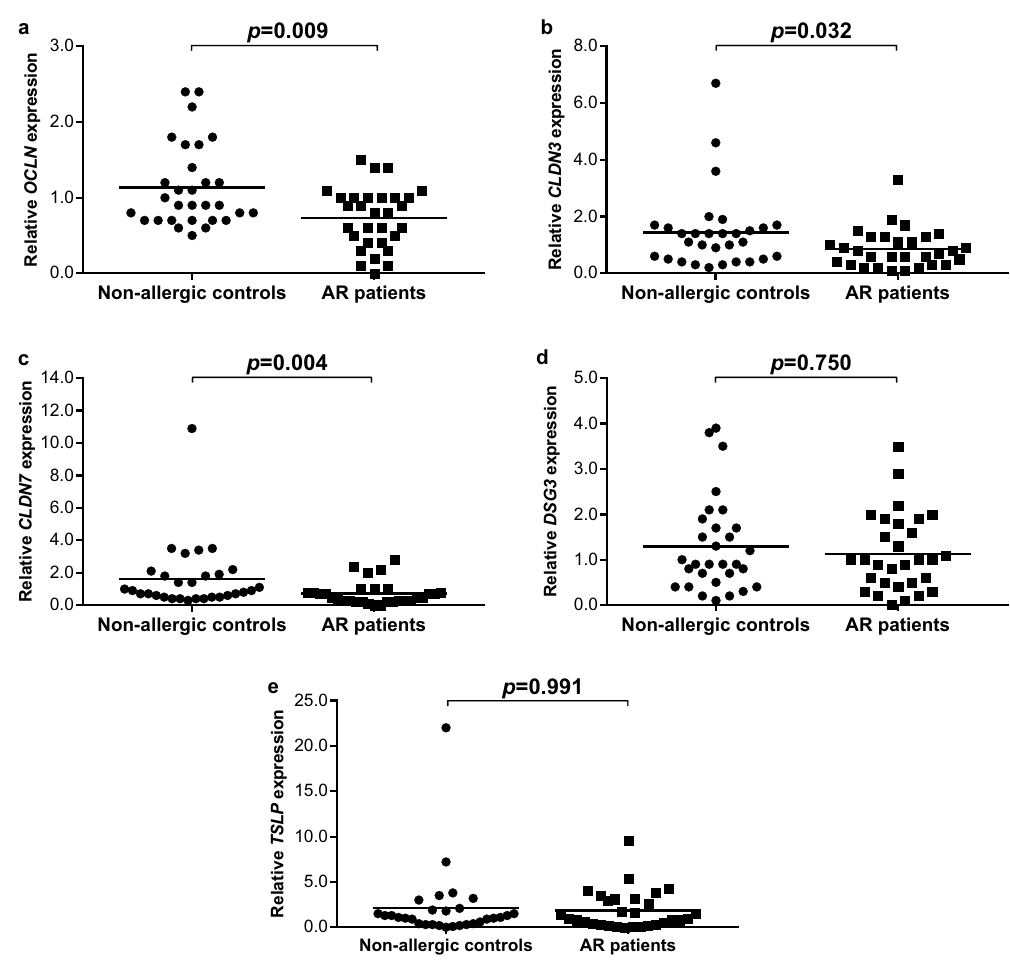
Figure 1. Relative OCLN ( a ), CLDN3 ( b ) , CLDN7 ( c ) , DSG3 ( d ) and TSLP ( e ) expression in non-allergic controls (n = 30) and AR patients (n = 30). Bar represents